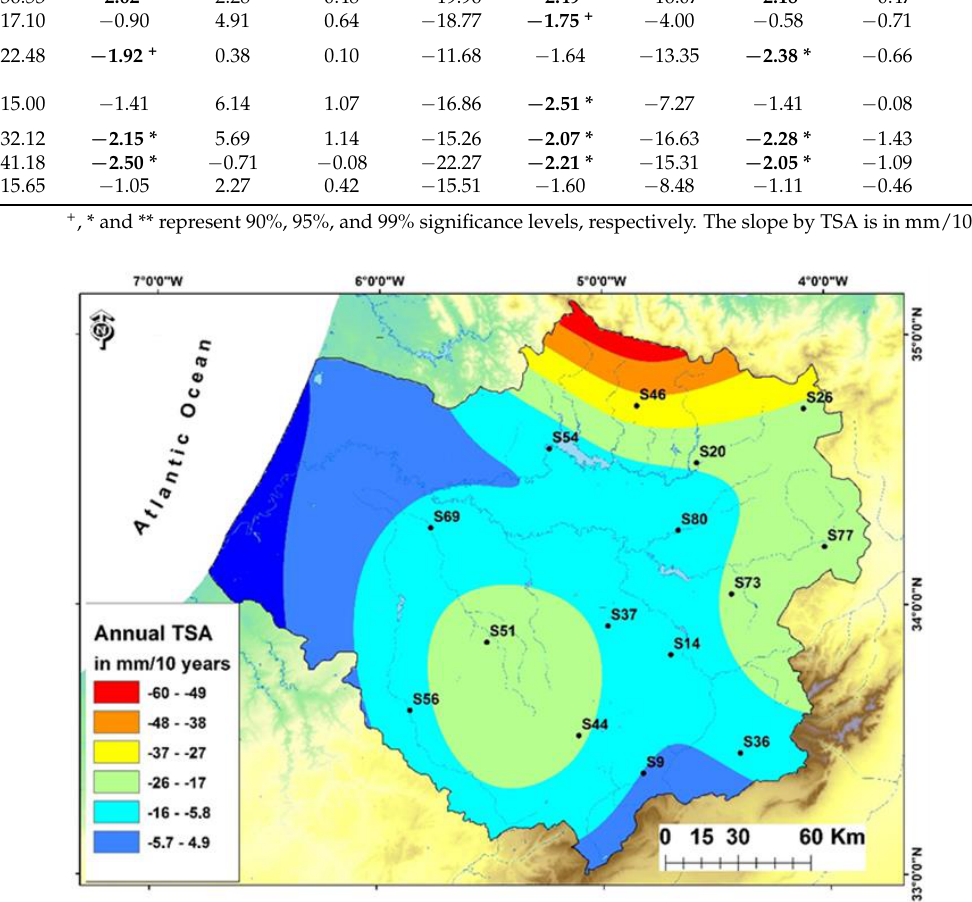
Figure 3. Theil – Sen Slope approach (TSA) for annual rainfall expressed in mm/10